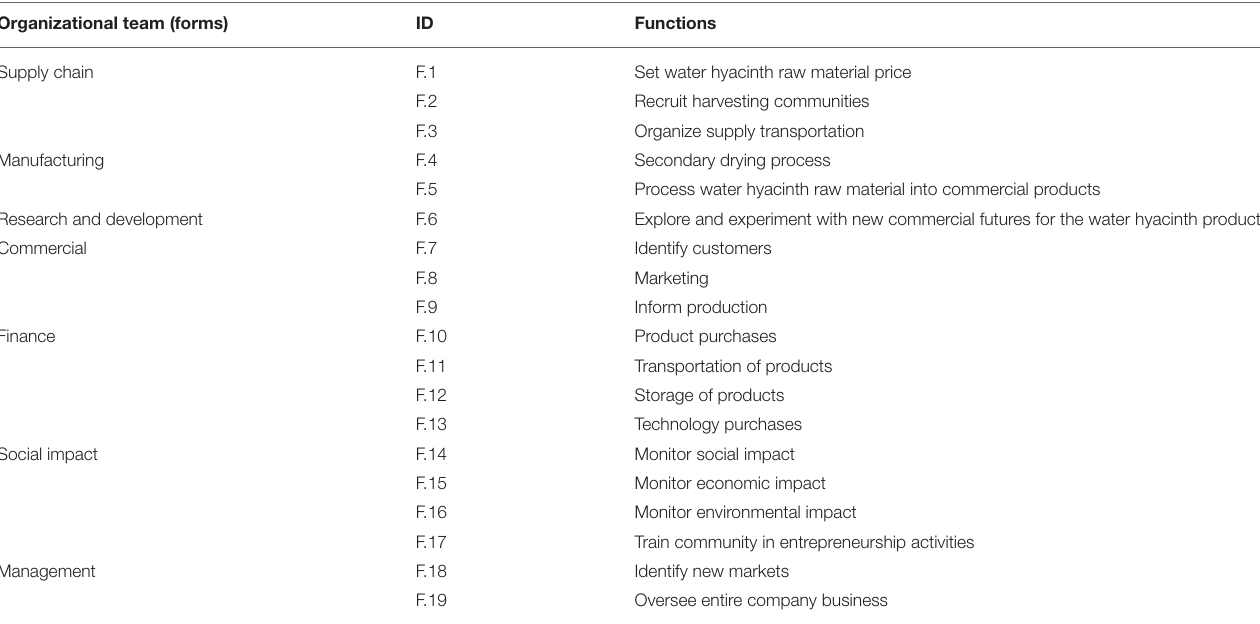
TABLE 3 | Summary of the system stakeholders, forms, functions, and desired outcomes (from the perspective of GKA). Organizational team